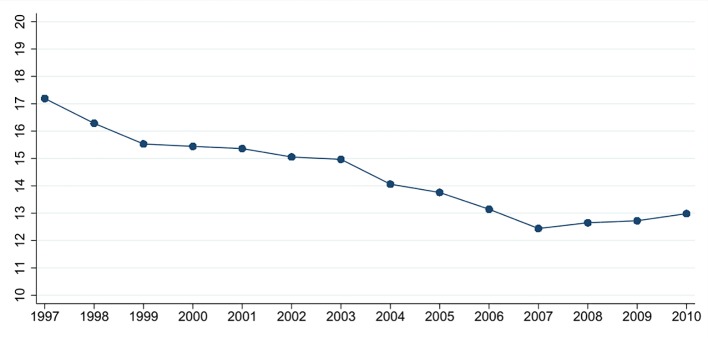
Yearly means of age- and gender-adjusted district suicide rates in Germany. Suicides per 100,000 inhabitants shown on the y-axis, observation years shown on the x-axis. Source: German Death Record, 1997 to 2010 - ed. by the German Federal Statistical Office (DESTATIS), STATA 15.0 was used to create this figure.